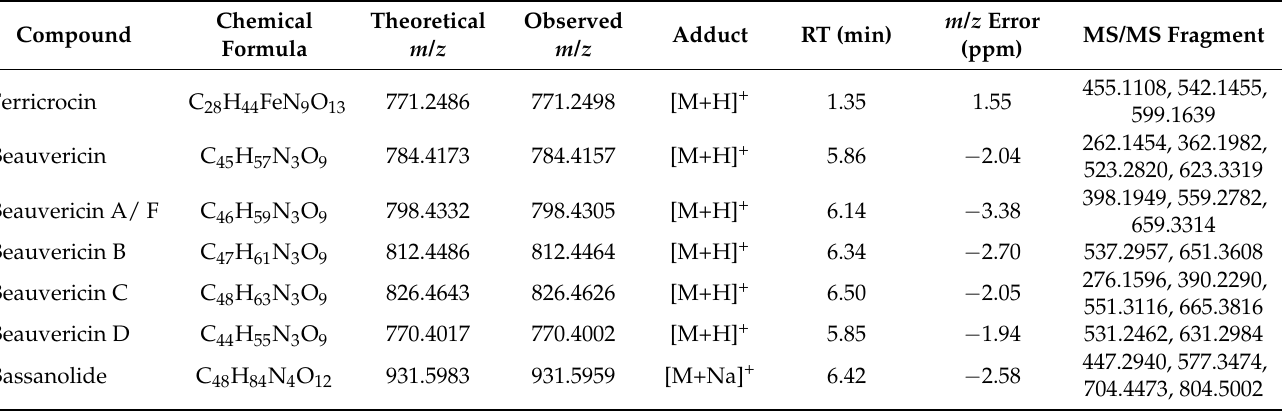
Table 2. Summary of classified insect-virulence metabolites and a siderophore identified from OEpks 15 and ∆ pks15 strains in culture media and in